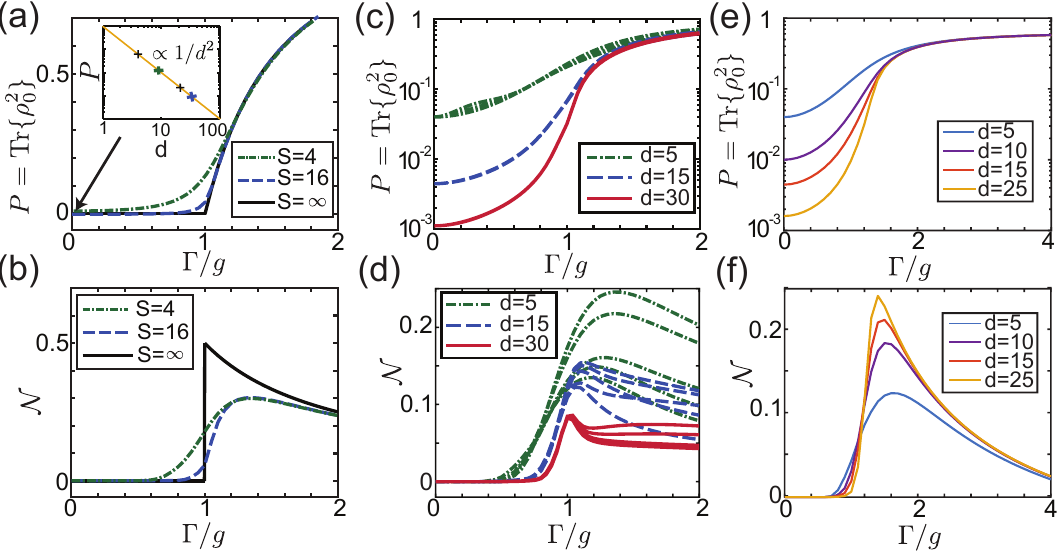
Figure 2: (a) Plot of the purity P of the steady state of a PT -symmetric spin dimer [ see Fig. 1(a) ] as a function of the dissipation rate and for different values of S . The inset shows that the purity satisfies P (cid:39) 1 / d 2 for Γ (cid:28) g . (b) Plot of the entangle- ment negativity N [ 52, 53 ] for the same model. In (c) and (d) the same